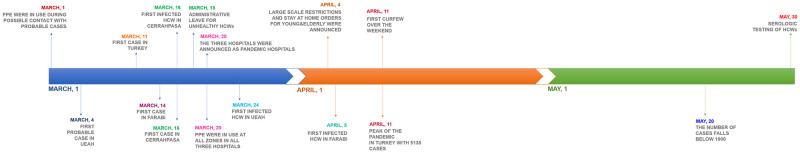
Timeline of COVID19 in three pandemic hospitals.